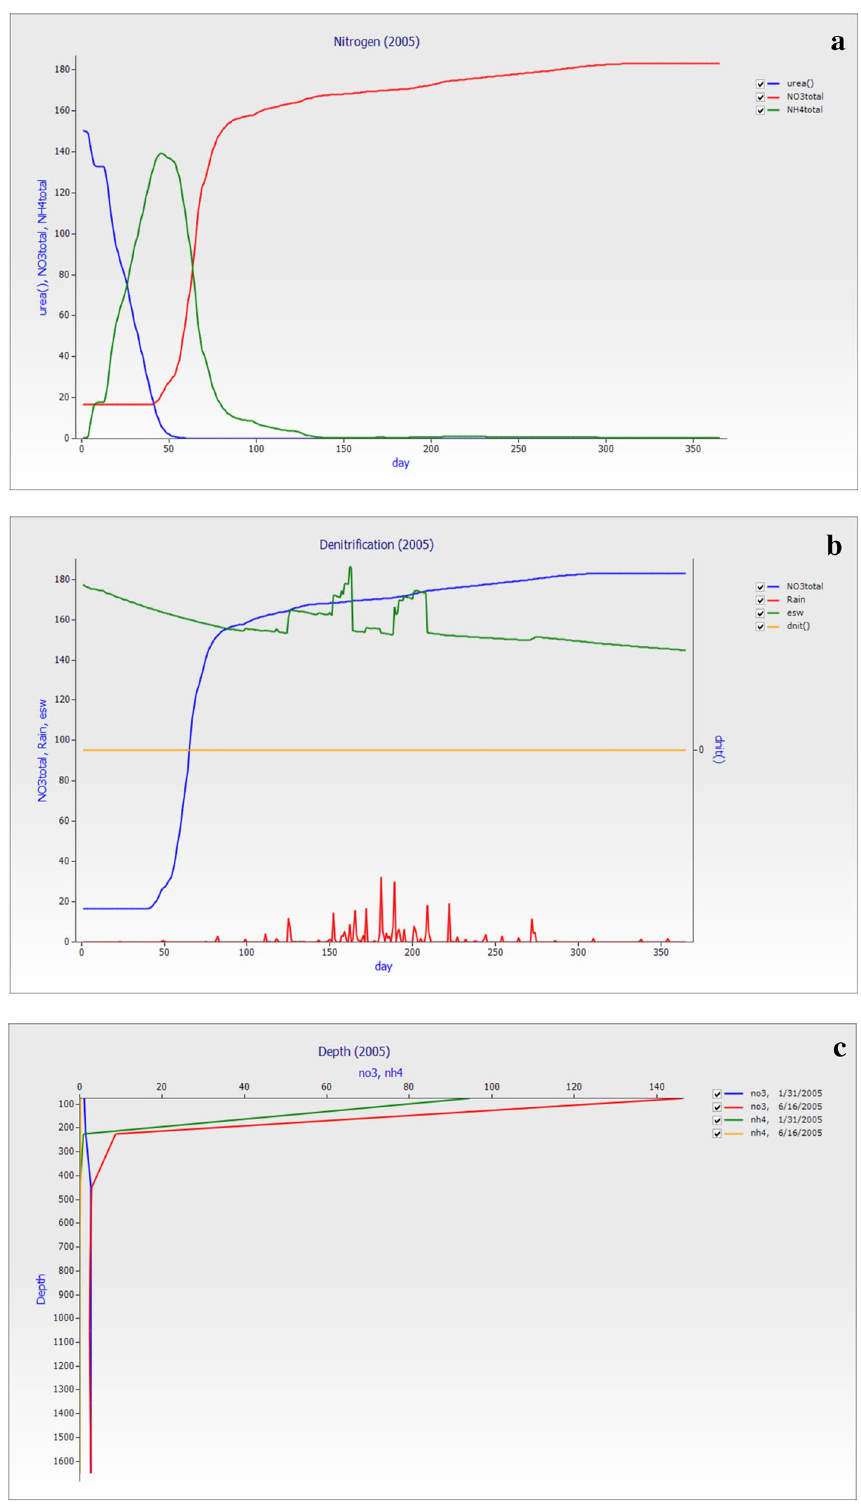
Figure 8. The graph was made on simulation datausing nitrogen model for the year 2005 ( a ) the nitrogen changes graph with different days of the year versus urea, total (NO 3− –N and NH 4+ –N), ( b ) the graph of day versus total NO 3− –N, Rain essential soil water (esw) and denitrification (dnit) while, ( c ) the graph of nitrate distribution through the soil depth at different dates in the